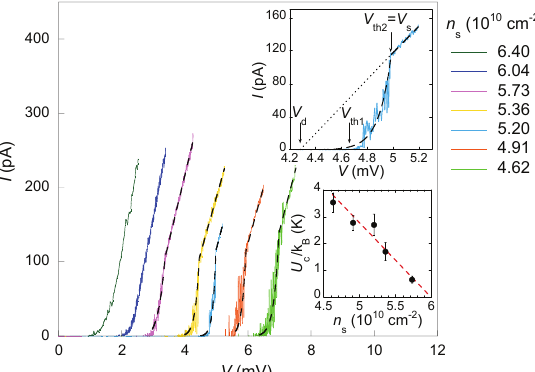
Figure 6. V − I curves are shown for different electron densities in the insulating state of a silicon MOSFET at a temperature of 60 mK. The dashed lines are fits to the data using Equation (6). The top inset shows the V − I curve for n s = 5.20 × 10 10 cm − 2 on an expanded scale; also shown are the threshold voltages V th1 and V th2 , the static threshold V s = V th2 , and the dynamic threshold V d that is obtained by the extrapolation of the linear region of the V − I curve to zero current. Bottom inset: activation energy U c vs. electron density. Vertical error bars represent standard deviations in the determination of U c from the fits to the data using Equation (6). The dashed line is a linear fit. From